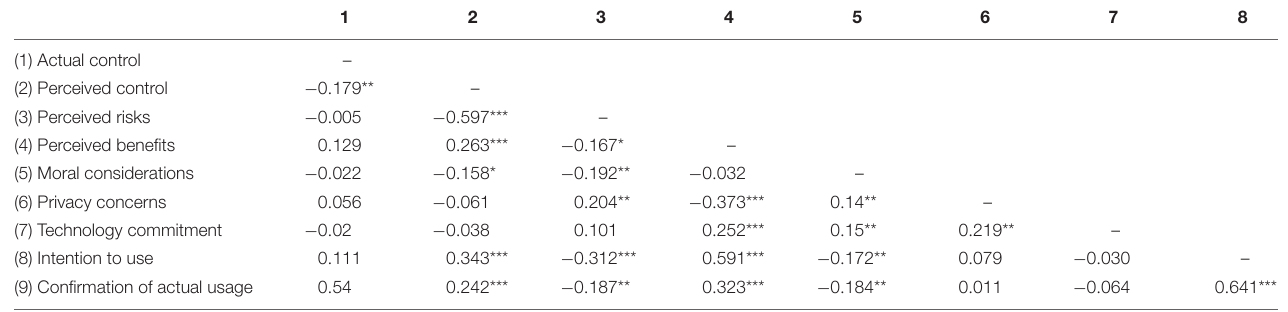
TABLE 3 | Bivariate correlations of the variables.